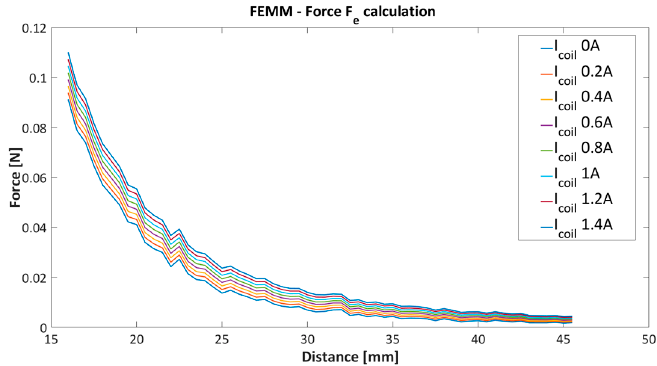
Figure 7. FEMM force calculation for different coil current.